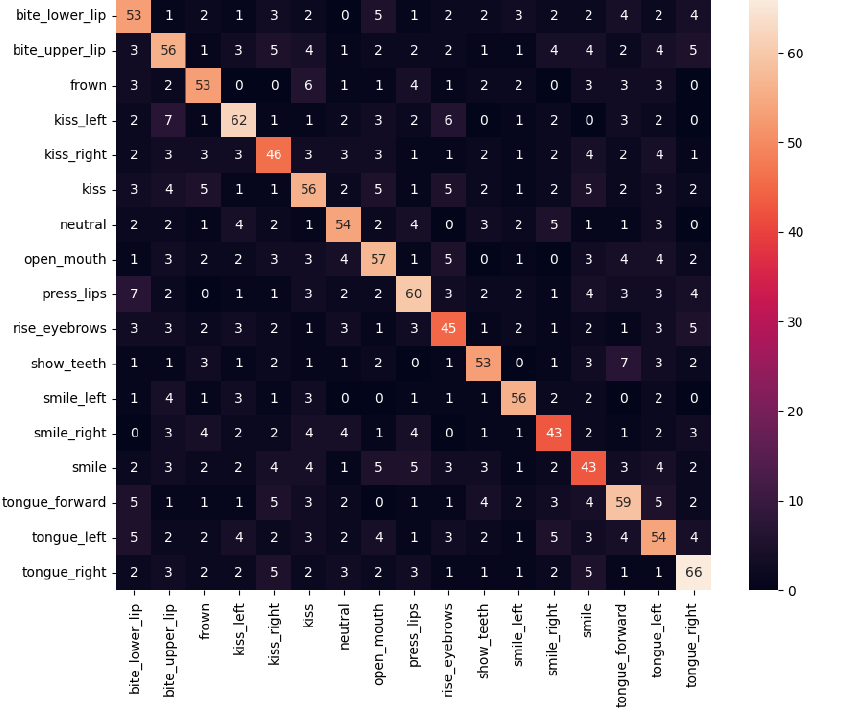
Figure 29. Confusion matrix of the trained orofacial gesture